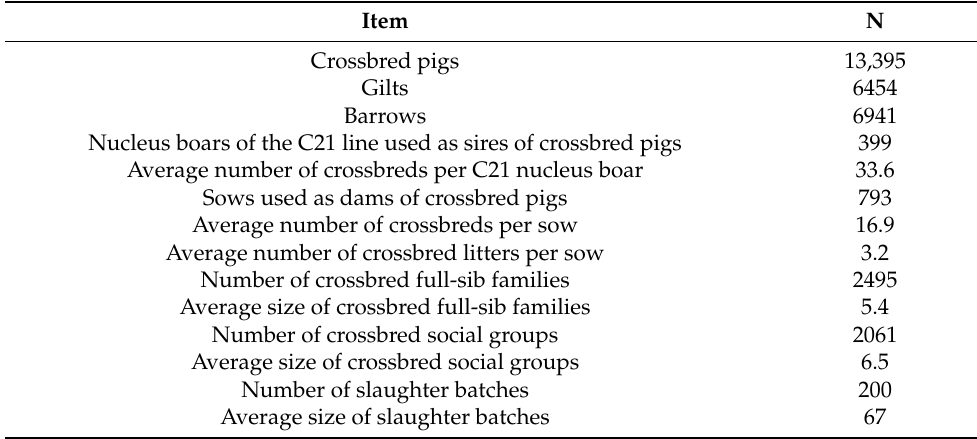
Table 1. Structure of the data used in the